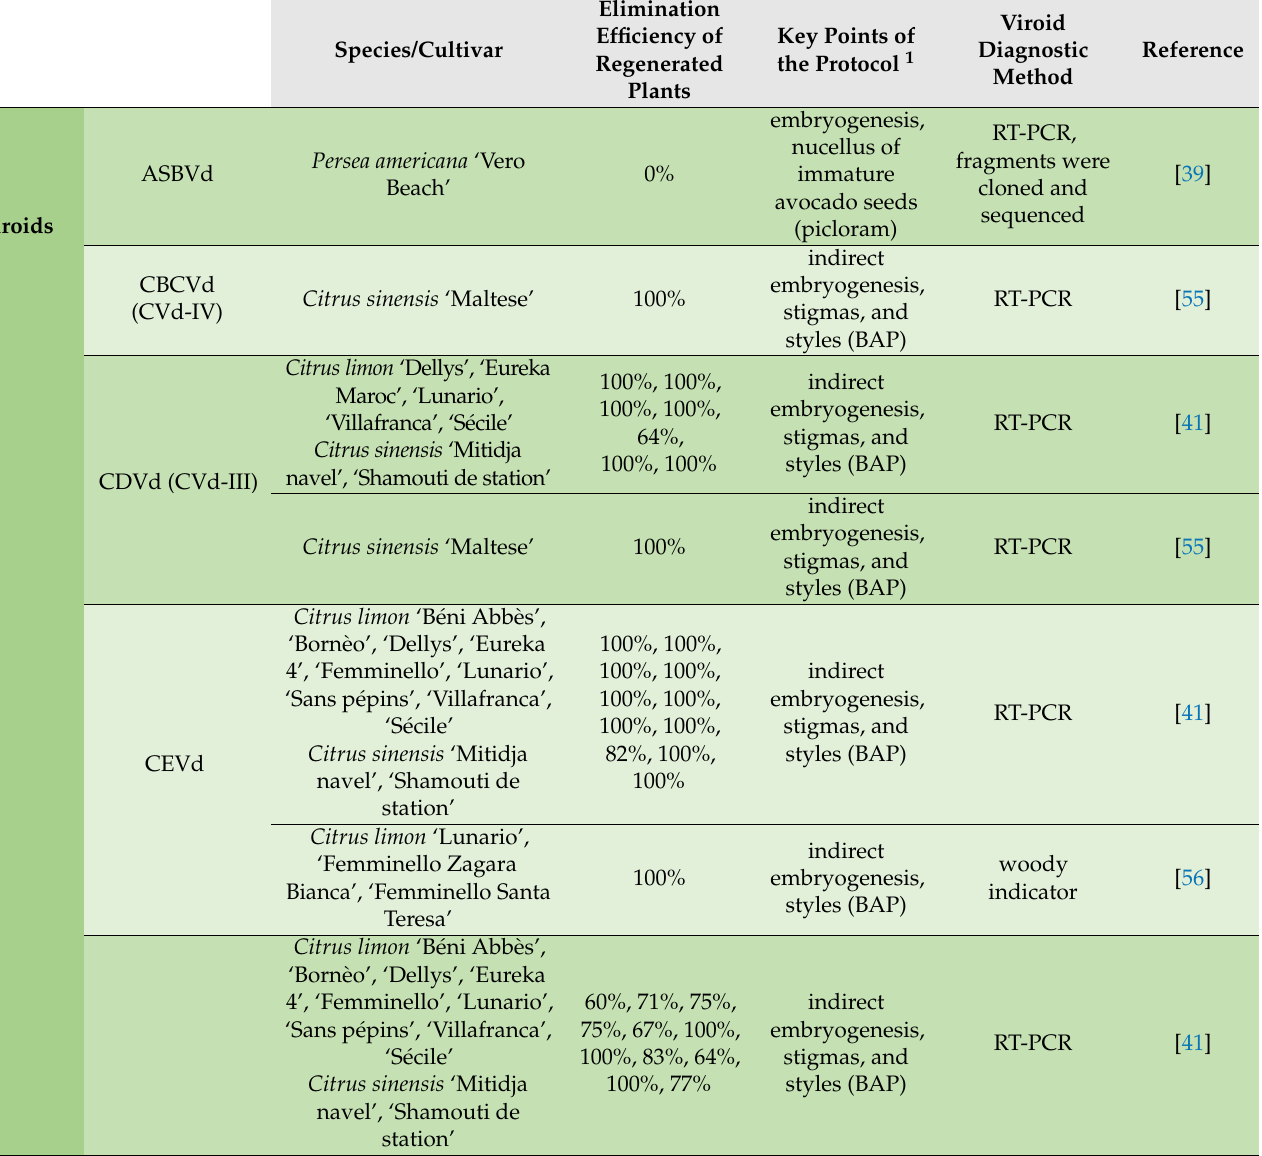
Table 3. The main results of the viroid elimination experiments via somatic embryogenesis in different